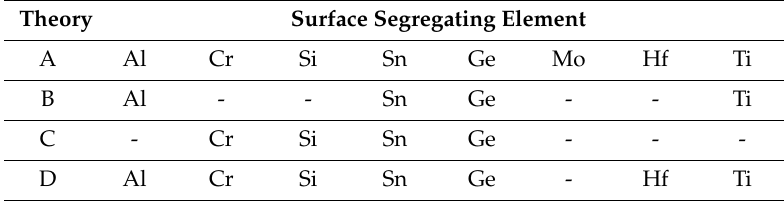
Table 7. Solutes in Nb-X binary alloys predicted to segregate to the surface. Theory Surface Segregating